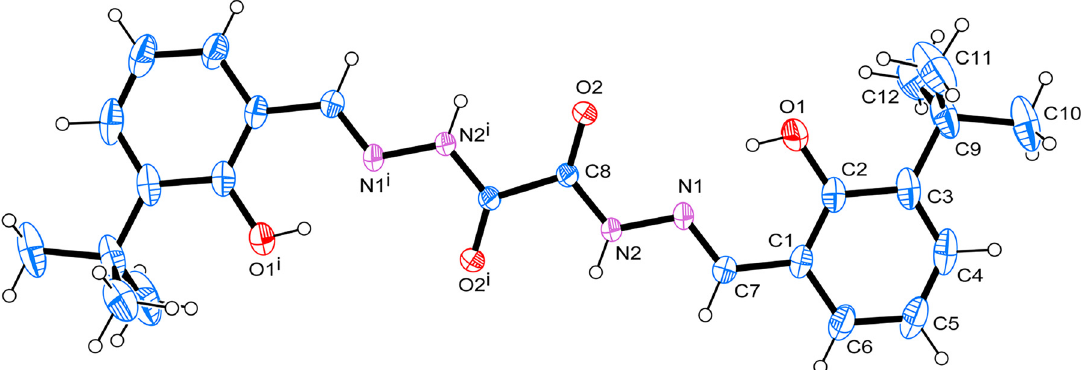
Table  : Data collection and